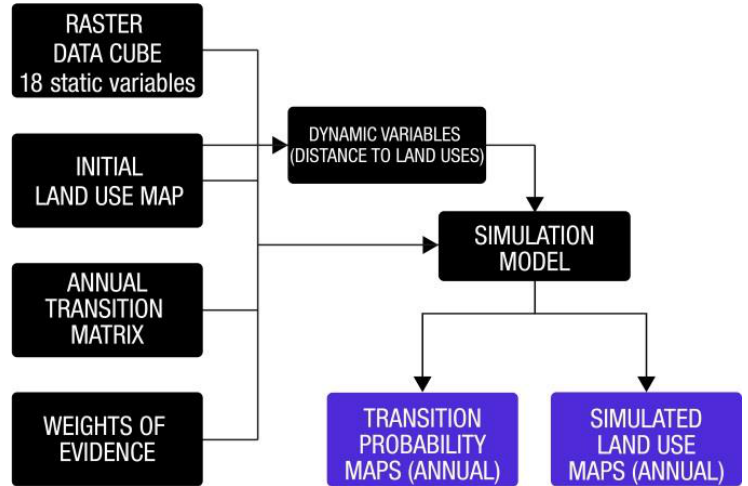
Figure 9. Simplified flowchart of the simulation step.